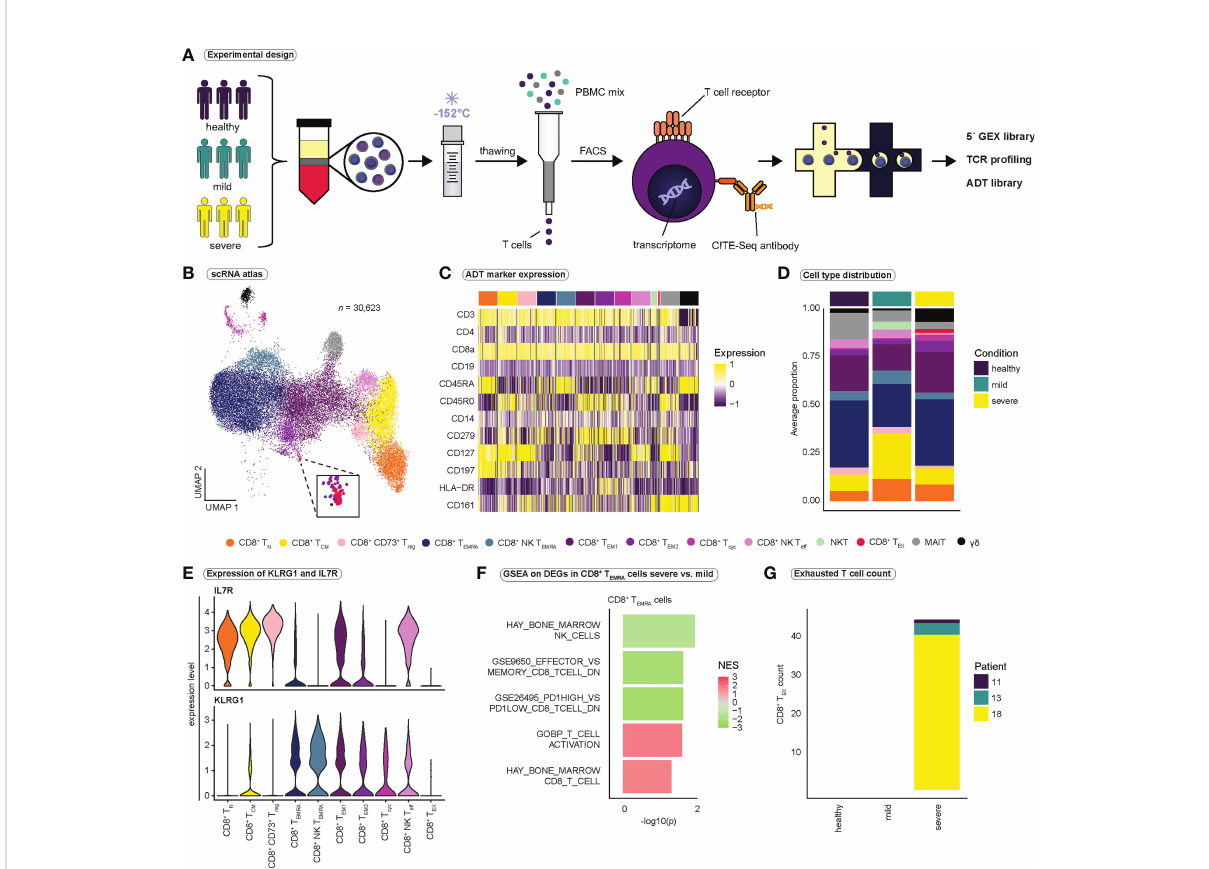
FIGURE 1 Study design and identi fi cation of functional subsets of CD8 + T cells. (A) Schematic overview of the study design. PBMCs were isolated from healthy volunteers, patients with mild, and patients with severe COVID-19. PBMCs were gradually frozen and stored at -152°C until further processing. After thawing, T cells were isolated using magnetic activated cell sorting. CD8 + T cells were obtained by FACS, and CD8 + T cells were then subjected to the 10x pipeline. (B) Integrated UMAP projection of all 13 CD8 + T cell subpopulations ( n = 30,623) (C) Scaled expression of antibody-derived tag (ADT) markers (CITE-seq) per CD8 + T cell subpopulation. (D) Average proportion of CD8 + T cell subsets for the healthy ( n = 2), mild ( n = 6), and severe ( n = 6) condition. Cell type proportions per patient are reported in Figure S1C. (E) Expression of KLRG1 and IL7R per CD8 + T cell population. (F) Selected gene sets enriched in CD8 + T EMRA cells when comparing severe to mild COVID-19 (for a full list of gene sets see Table S4) (G) Number of exhausted CD8 + T cells per condition and patient. FACS, fl uorescence activated cell sorting; TCR, T cell receptor; GEX, gene expression; ADT, antibody-derived tag; CD8 + T N , CD8 + naïve T cells; CD8 + T CM , CD8 + central memory cells; CD8 + CD73 + Treg, CD8 + CD73 + regulatory T cells; CD8 + T EMRA , CD8 + terminally differentiated effector memory cells re-expressing CD45RA; CD8 + NK T EMRA , CD8 + NK-like terminally differentiated effector memory cells re-expressing CD45RA; CD8 + T EM1 , CD8 + effector memory cells 1; CD8 + T EM2 , CD8 + effector memory cells 2; CD8 + T cyc , CD8 + cycling effector cells; CD8 + NK T eff , CD8 + NK-like early effector T cells; NKT, atypical NKT cells; CD8 + T EX , CD8 + exhausted T cells; MAIT, Mucosal associated invariant T cells; gd , gd T cells; GSEA, gene set enrichment